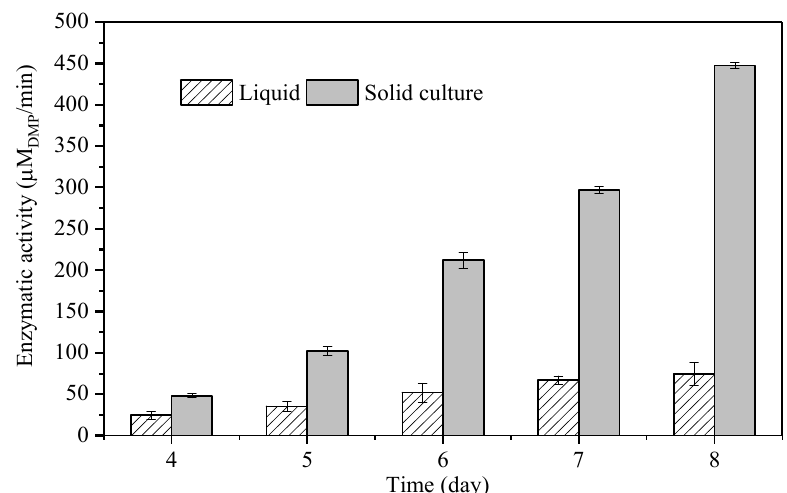
Figure 3. Enzymatic activity in the crude solution from liquid and solid culture. Note, 100 mL of Milli-Q water was added in the solid culture from day 4. The data were the average and standard deviation of five cultures.